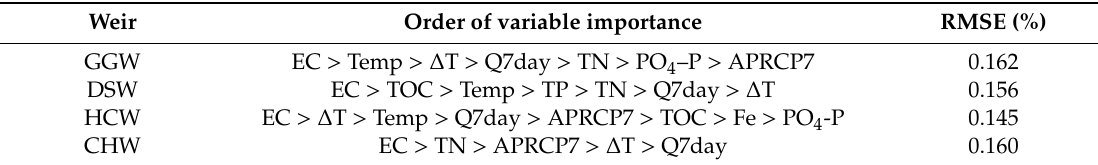
Table 3. Variables selected by recursive feature elimination (RFE) and order of importance for each weir; Gangjeong Goryeong weir (GGW), Dalseong weir (DSW), Hapcheon Changnyeong weir (HCW), and Changnyeong Haman weir (CHW). Note: see the main text for definitions of abbreviated variables.